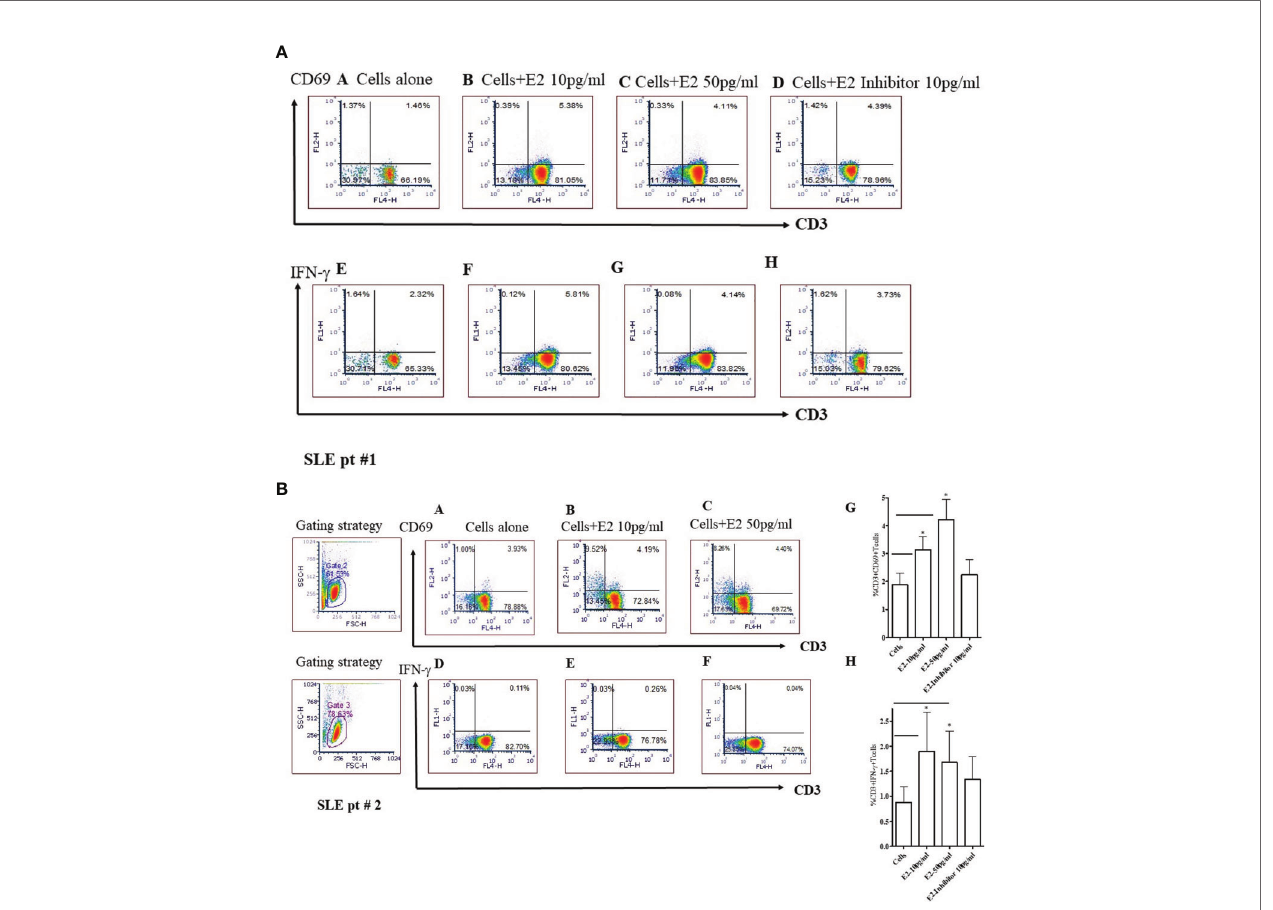
FIGURE 7 | 17 b -estradiol (E2) increases the percent expression of CD3 + CD69 + and CD3 + IFN g + T cells in SLE patients. Female SLE patient peripheral blood mononuclear cells (2x10 6 cells) were obtained and cultured for 24 hours in serum-free media. Cells were stained with anti-CD3, anti-IFN g and, anti-CD69 Abs and analyzed by FACS. For intracellular IFN g staining, cells were fi rst fi xed, permeabilized (as per manufacturer ’ s protocol; BD Biosciences, San Jose, CA) and stained. Cells were washed two times with PBS and data acquired at the UCLA Flow Cytometry Core Facility. Data were analyzed using FCS Express ™ De Novo software (Thornhill, Ontario, Canada). SLE pt #1. Figure 7A : CD69: Panels (A) : Cells alone; (B) : Cells + E2 (10 pg/ml); (C) Cells + E2 (50 pg/ml); (D) Cells + E2 (10 pg/ml) + E2 inhibitor - estrogen receptor alpha antagonist, ICI-182780 (10 pg/ml). IFN- g : (E) Cells alone; (F) Cells + E2 (10 pg/ml); (G) Cells + E2 (50 pg/ml); (H) Cells + E2 (10 pg/ml) + E2 inhibitor (10 pg/ml). SLE pt #2. Figure 7B : CD69: Panels (A) Cells alone; (B) Cells + E2 (10 pg/ml); (C) Cells + E2 (50 pg/ml). IFN- g : Panels (D) Cells alone; (E) Cells + E2 (10 pg/ml); (F) Cells + E2 (50 pg/ml), (G) Combined data for CD3 + CD69 + from SLE patients (n=8). *p < 0.05. (H) Combined data from SLE patients (n=6) for CD3 + IFN g + T cells; *p <